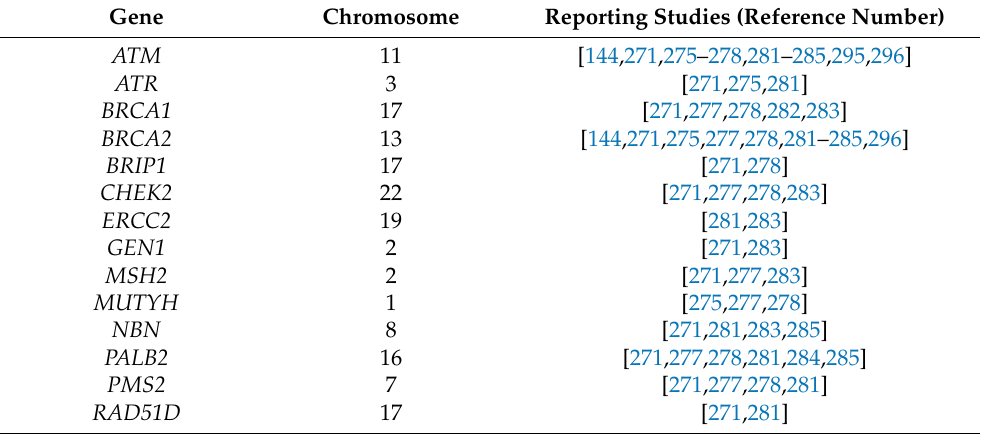
Table 1. DNA repair genes described as candidate PrCa susceptibility and/or poor prognosis genes in more than one next generation sequencing